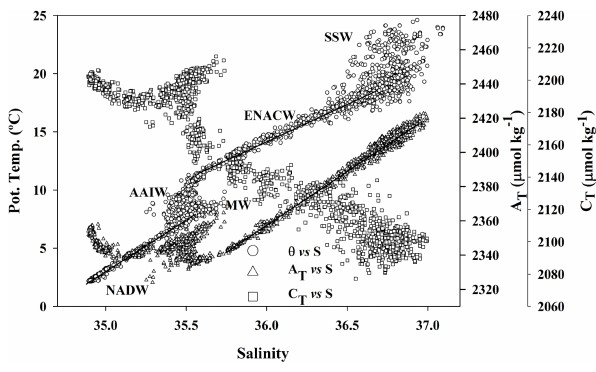
Fig. 8. Potential temperature vs. salinity relationship at the ESTOC site (open circles). SSW, ENACW, AAIW, MW and NADW indi- cate surface sea water, East North Atlantic central water, Antarctic Intermediate water, Mediterranean water and North Atlantic deep water. Lines represent the hypothetical linear mixing lines between two water types. A T (open triangles) and C T (open squares) vs. salinity relationships are also